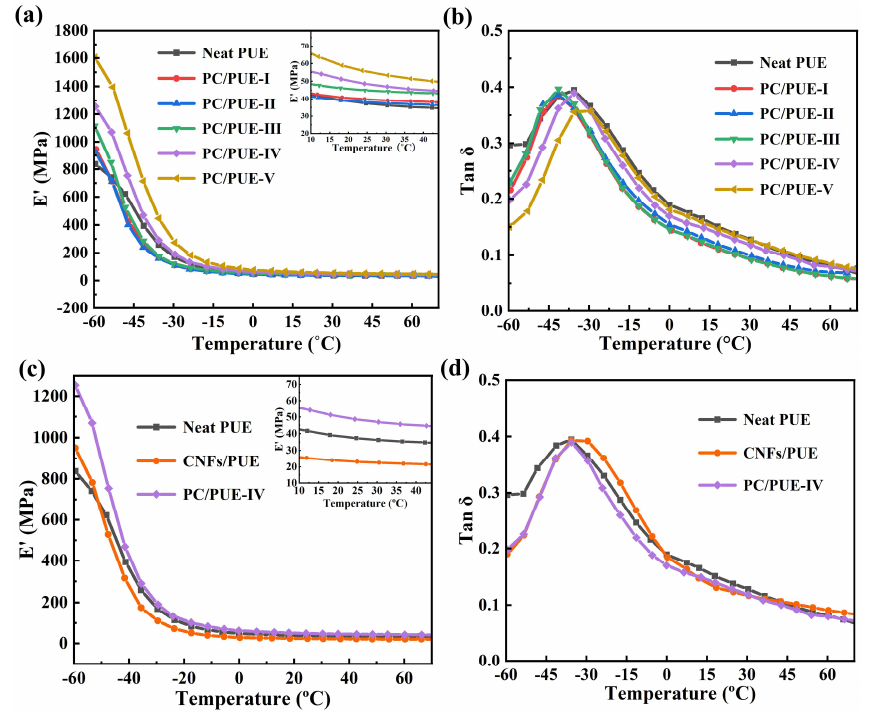
Figure 10. ( a ) E’ and ( b ) Tan δ as a function of temperature for Neat PUE and PDA@CNFs/PUE, ( c ) E’, and ( d ) Tan δ as a function of temperature for Neat PUE, CNFs/PUE, and PC/PUE– Ⅳ .